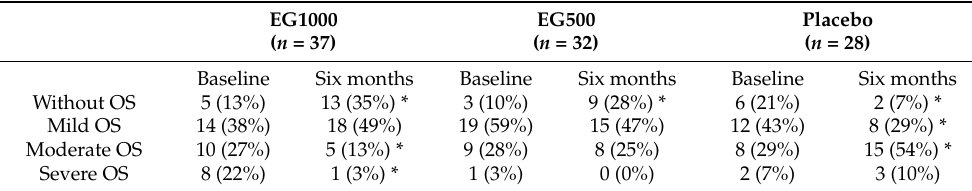
Table 4. Oxidative stress index in the study groups: baseline and after six months.